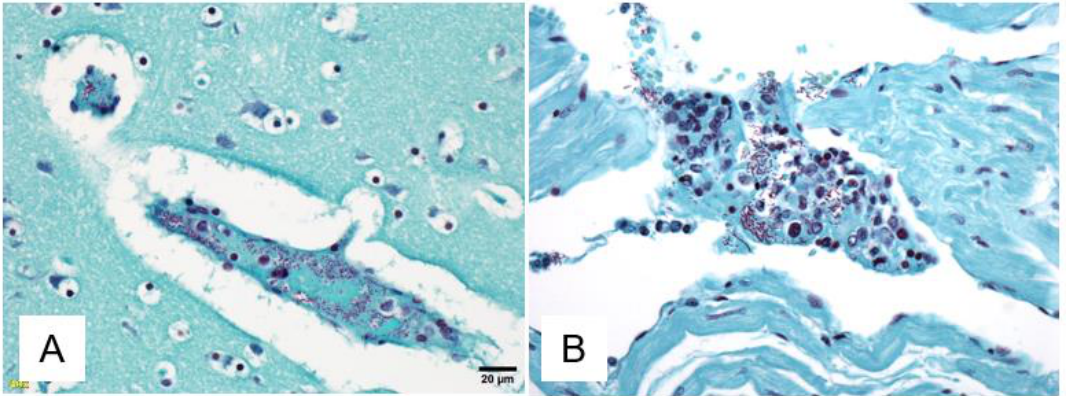
Figure 5. ( A , B ). Gram stain of tissues demonstrating evidence of gram-negative bacteremia in two different NHPs. ( A ) Demonstrates pathological evidence of disseminated gram-negative bacteria in the thalamus, 400×. ( B ) Demonstrates pathological evidence of disseminated gram-negative bacteria in the right heart, 400×.